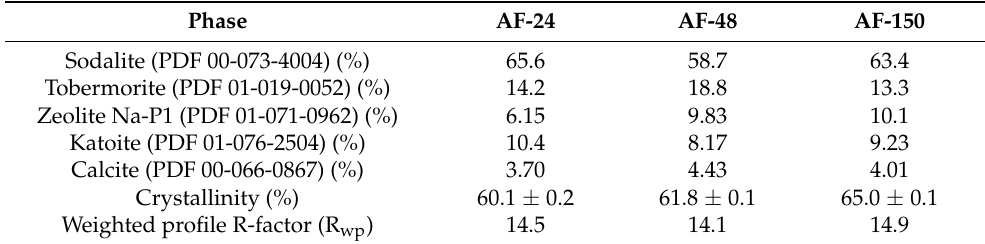
Table 3. Compositions of the hydrothermal reaction products of amber container glass and alu- minium foil.